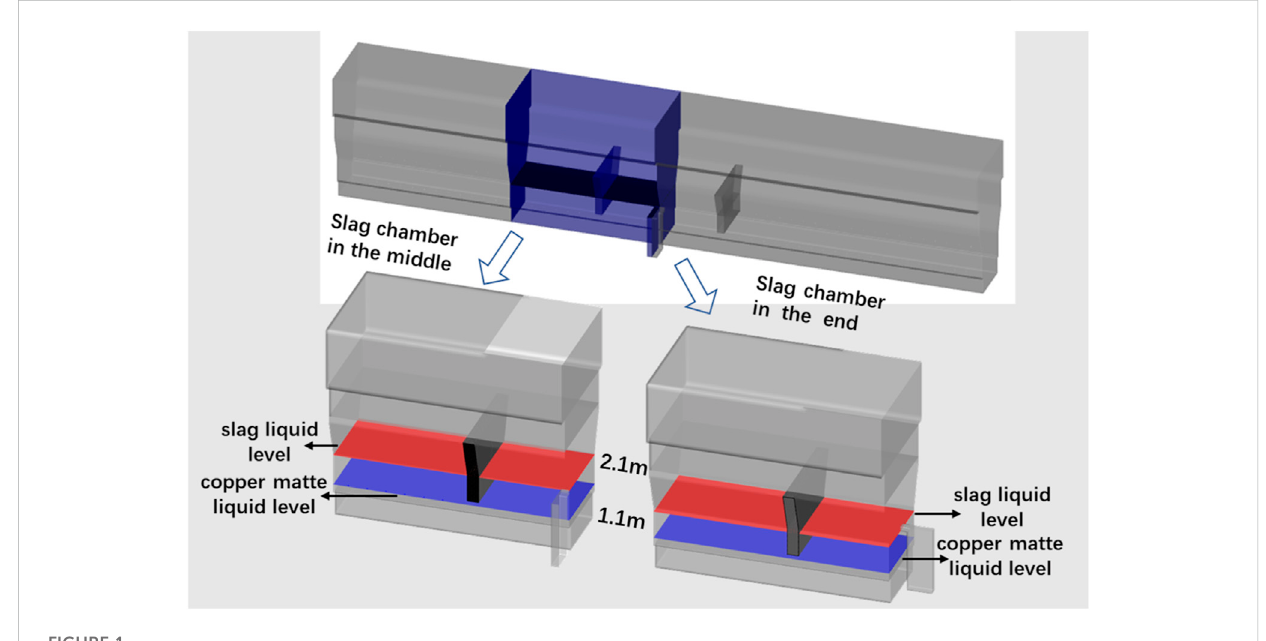
FIGURE 1 Schematic diagram of oxygen-enriched side-blown furnace body